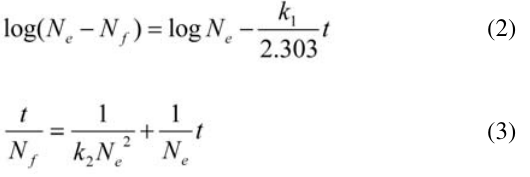
Table 1. Comparison between pseudo-first- and pseudo-second kinetic models for MS-AMP regarding the adsorption of Cu(II), Cd(II), Zn(II), Pb(II), and Ni(II).